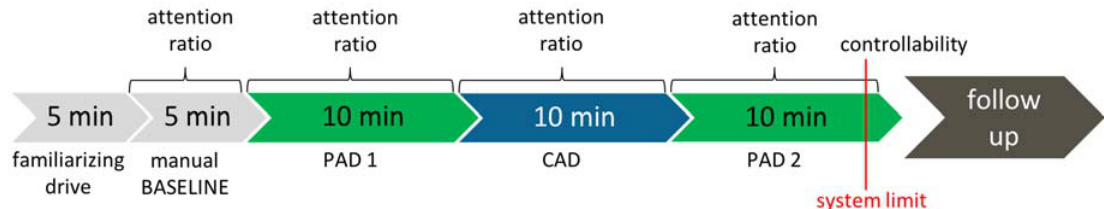
Figure 2. A schematic depiction of the driving sequences. A first familiarizing drive and a manual baseline are followed by a sequence of driving partially automated driving (PAD), conditionally automated driving (CAD) and then PAD again. Mode awareness is operationalized by the comparison of attention to driving related areas of interest during the drives and the controllability of a system limit at the end of the second PAD drive.